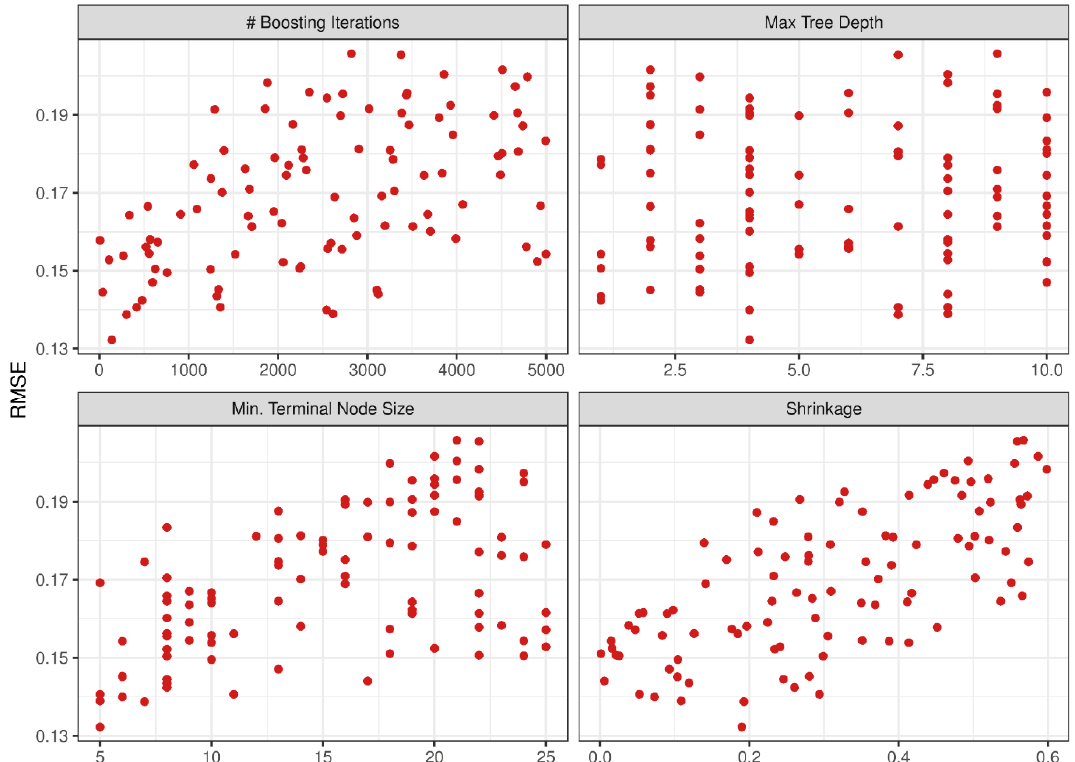
Figure 7. Performance of the SGB model in this study.